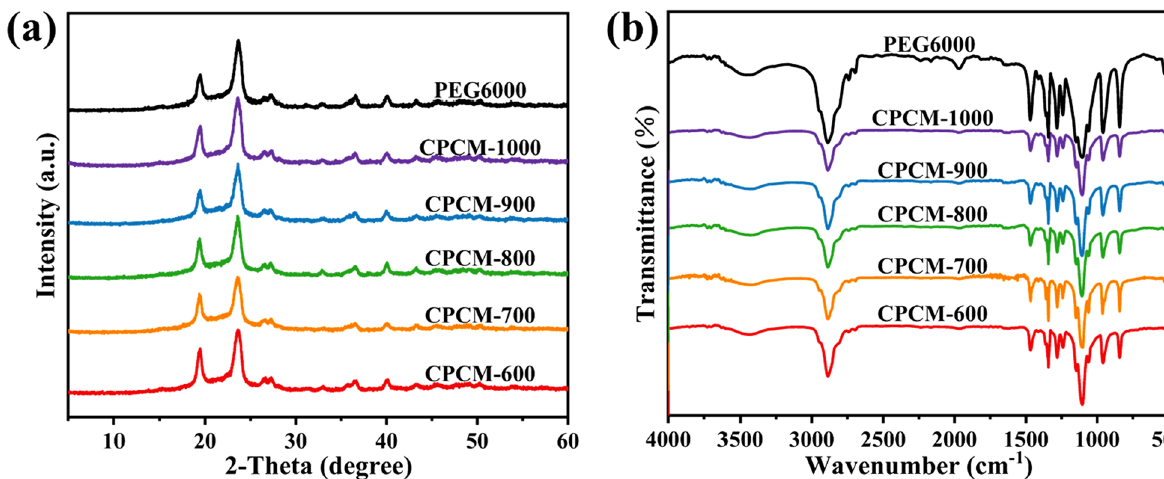
Fig. 7 a XRD patterns and b FT-IR spectra of PEG6000, CPCM-600, CPCM-700, CPCM-800, CPCM-900 and CPCM-1000